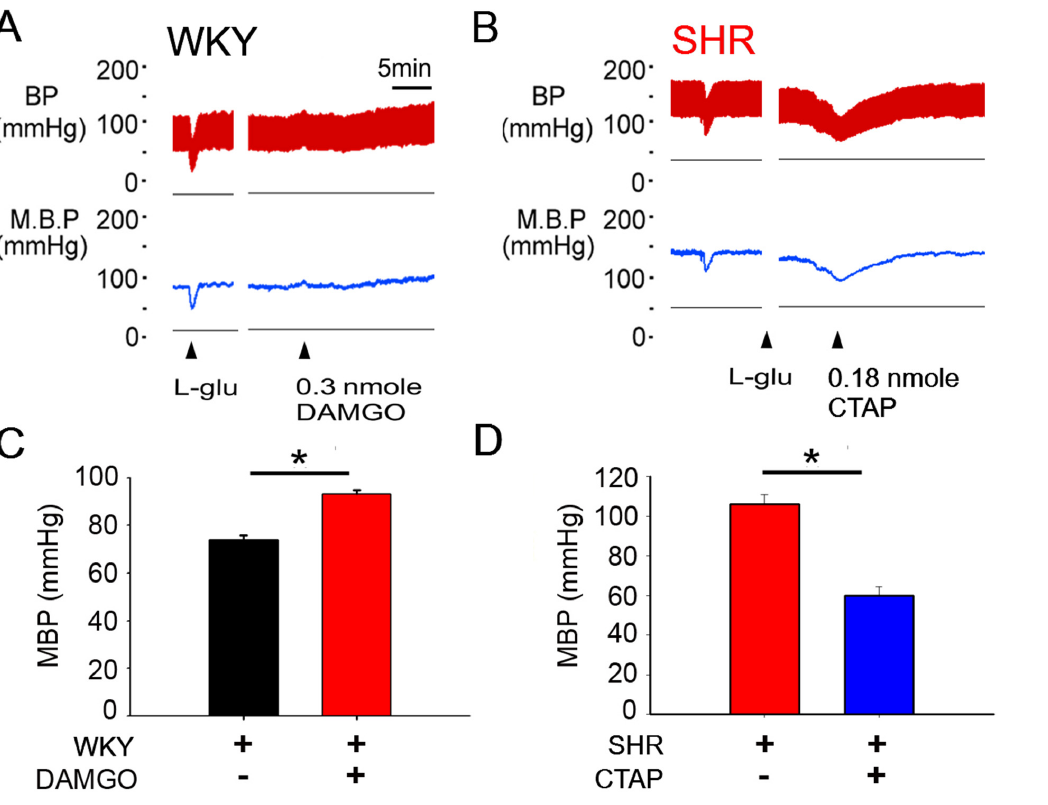
Figure 3. Activation of μ OR in the NTS and cardiovascular regulation of WKY rats and SHRs. ( A ) Representative tracings demonstrating the cardiovascular effects of [D-Ala 2 , MePhe 4 , Gly 5 -ol]-enkephalin (DAMGO) (0.3 nmol) injected into the unilateral NTS of anesthetized WKY ( ▲ time of injection). ( B ) Representative BP recordings of an intra-NTS microinjection of the μ OR antagonist CTAP in hypertensive SHRs ( ▲ time of injection). ( C ) Bar graphs showing the effects of 10-min treatment with DAMGO on the mean blood pressure (MBP) of anesthetized WKY. ( D ) Bar graphs showing the effects of 10-min treatment with DAMGO on the mean blood pressure (MBP) of anesthetized SHRs. ( E , F ) Representative red fluo- rescence images and the statistical analysis for Endomorphin-2-positive cells after DAMGO or CTAP treatment. The im- ages were photographed at ×400 and 1000 magnification. The Mann–Whitney U-test was used for statistical analysis. Bar values are shown as mean ± SEM ( n = 6); * p <0.05 versus control.